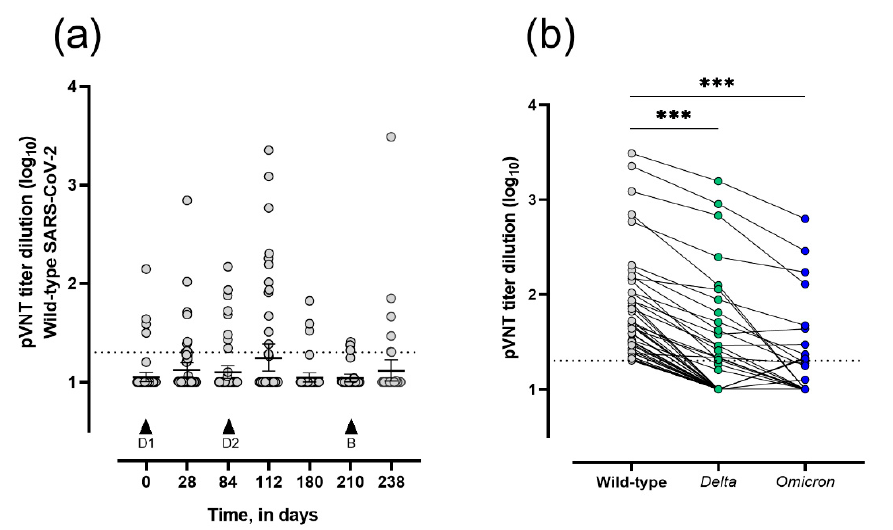
Figure 3. Evolution of wild-type- and SARS-CoV-2 variant-neutralizing capacities in vaccinated- LTRs. Data are expressed in log 10 . ( a ) Dilution titers of anti-SARS-CoV-2 IgG at day 0 (n = 49), 28 (n = 47), 84 (n = 49), 112 (n = 44), 180 (n = 42), 210 (n = 32), and 238 (n = 28), assessed by pseudovirus neutralization test (pVNT) (geometric mean ± 95% CI). Statistical analysis by Kruskal–Wallis test followed by a post hoc Dunn’s test provided non-significant results. ( b ) Paired Delta and Omicron SARS-CoV-2 neutralizing capacities of wild-type-positive samples (n = 45) assessed by pVNT (geometric mean ± 95% CI). Dotted black lines represent the positivity cut-offs for neutralization (>20 dilution titer, i.e., 1.3 in log 10 ). *** p < 0.001 wild-type vs. Delta and Omicron by the Kruskal–Wallis test followed by a post hoc Dunn’s test. D1 and D2 correspond to the first and second doses of ChAdOx1, respectively; B corresponds to the booster dose, BNT162b2.